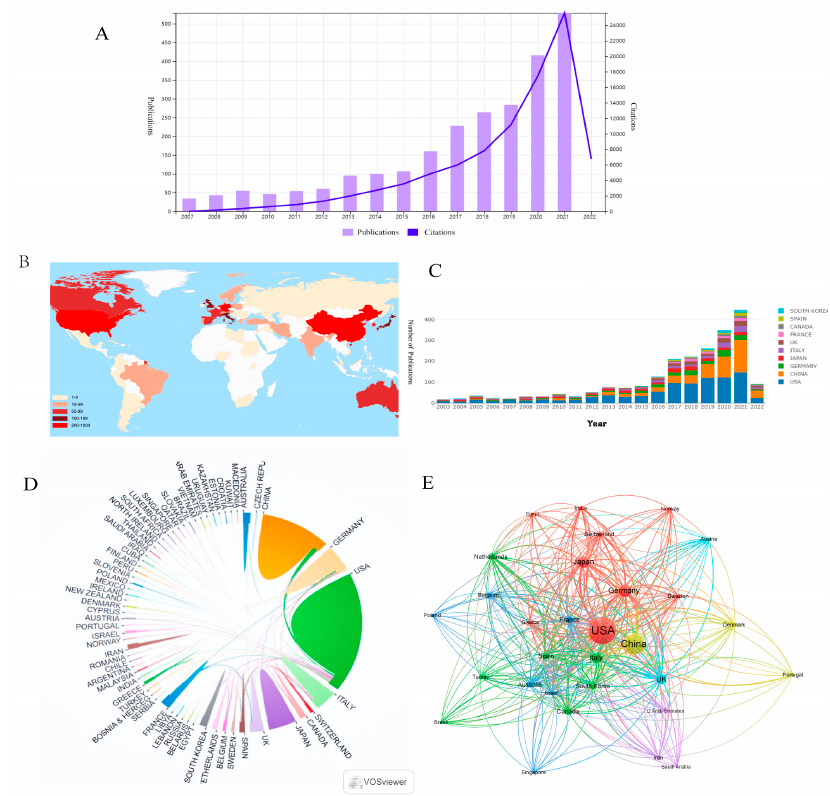
Figure 2. ( A ) The annual number and total citations of articles related to pancreatic cancer im- munotherapy published from 2007 to 2021. ( B ) World map based on the number of articles of coun- tries/regions. ( C ) The trend of annual number of articles from top ten countries/regions. ( D ) The inter- national collaborations between countries/regions. The links between countries/regions represented the frequency of the collaborations. ( E ) The citation network between the top 30 countries/regions in terms of article quantity, generated by VOSviewer. The size of nodes indicates the number of articles, while the thickness of links indicates the citation